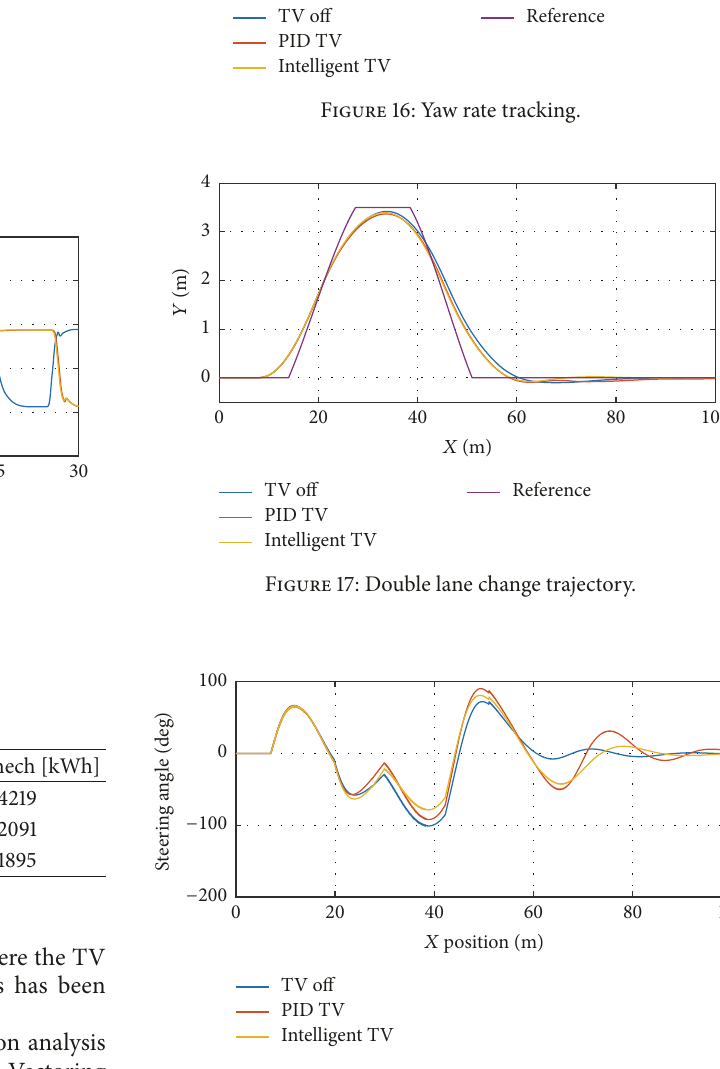
Figure 18: Steering